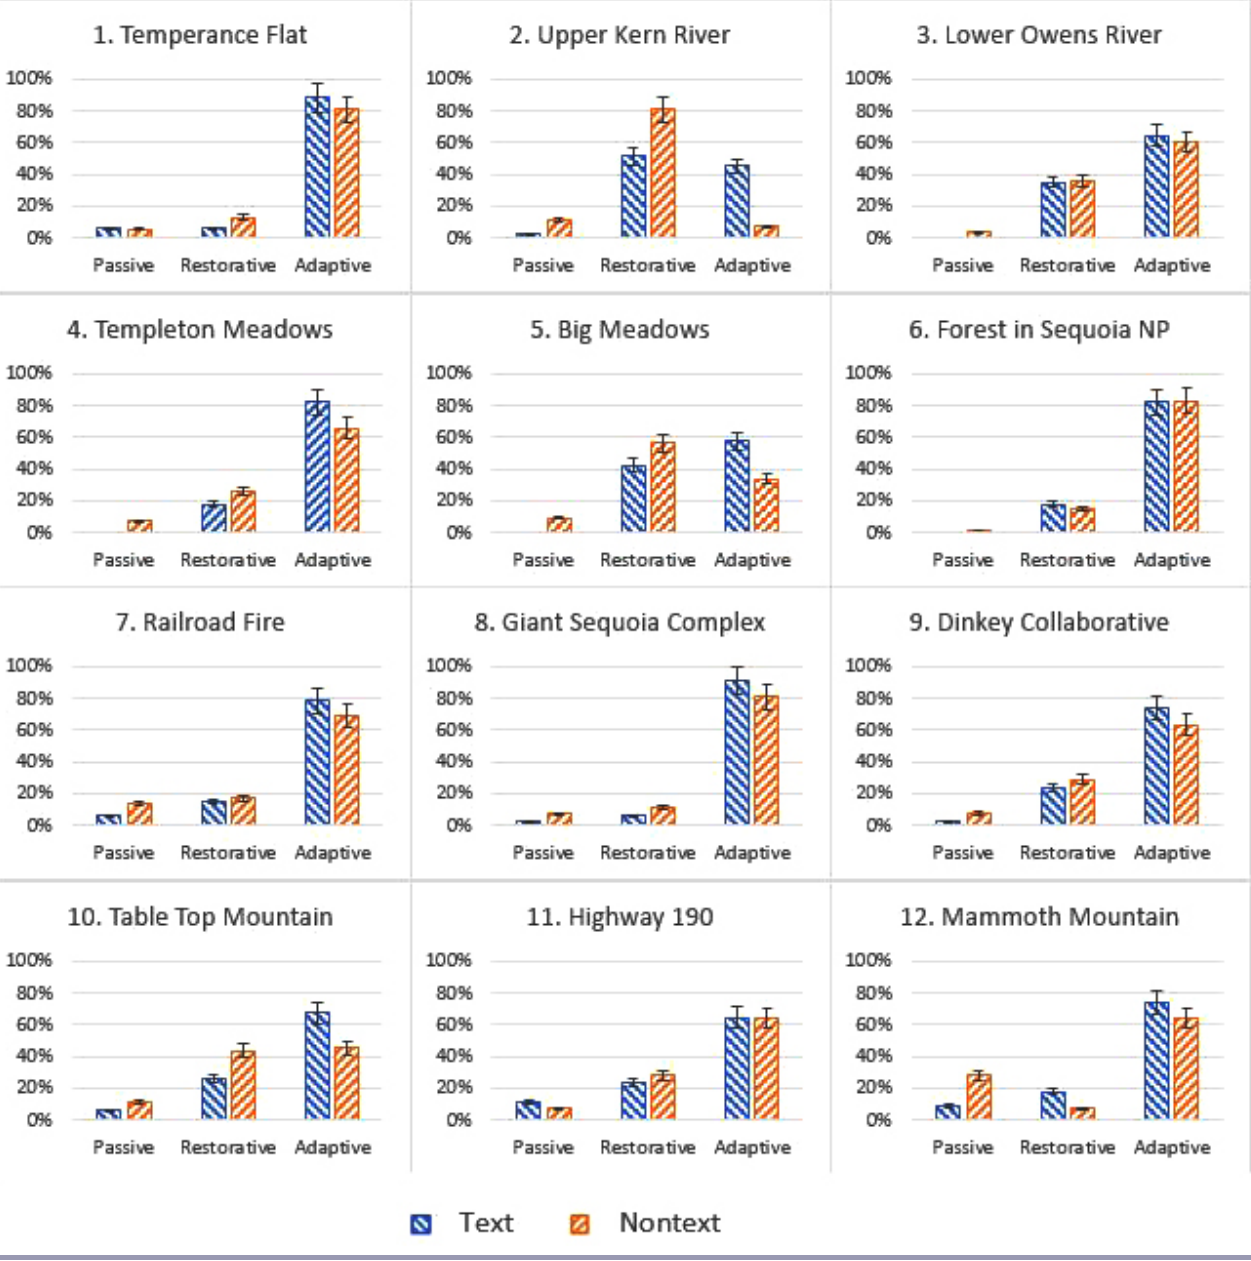
Fig. 4 . Percentage of responses for survey version with supporting text accompanying images versus percentage of responses for version without supporting text/nontext for each management strategy by site (with standard 10% error